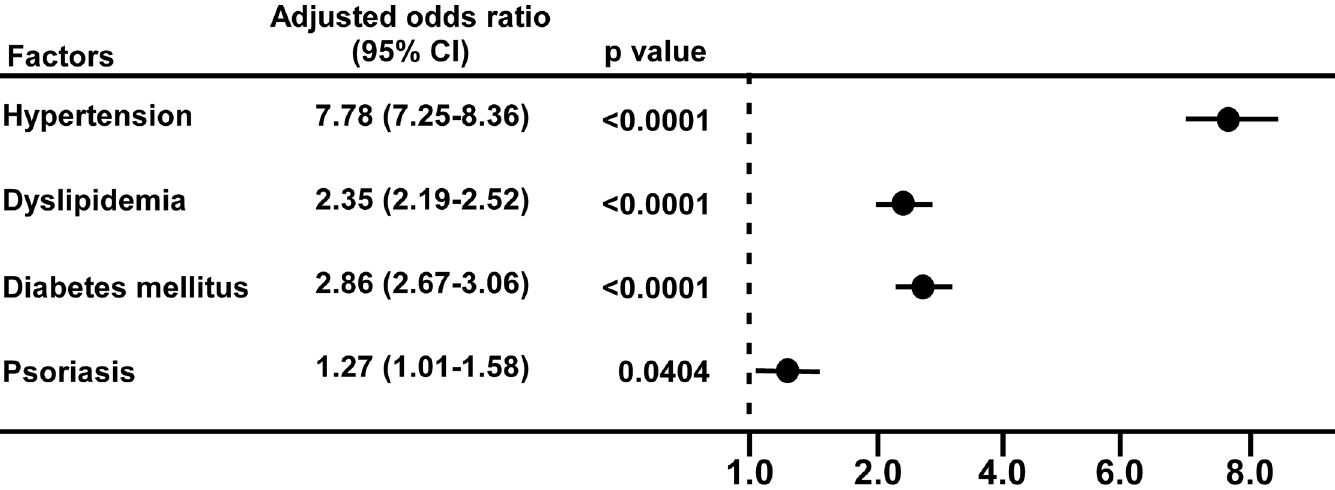
Fig 1. Multivariate logistic regression analysis of the factors related to coronary heart disease. Data are adjusted for hypertension, dyslipidemia, diabetes mellitus, and psoriasis.